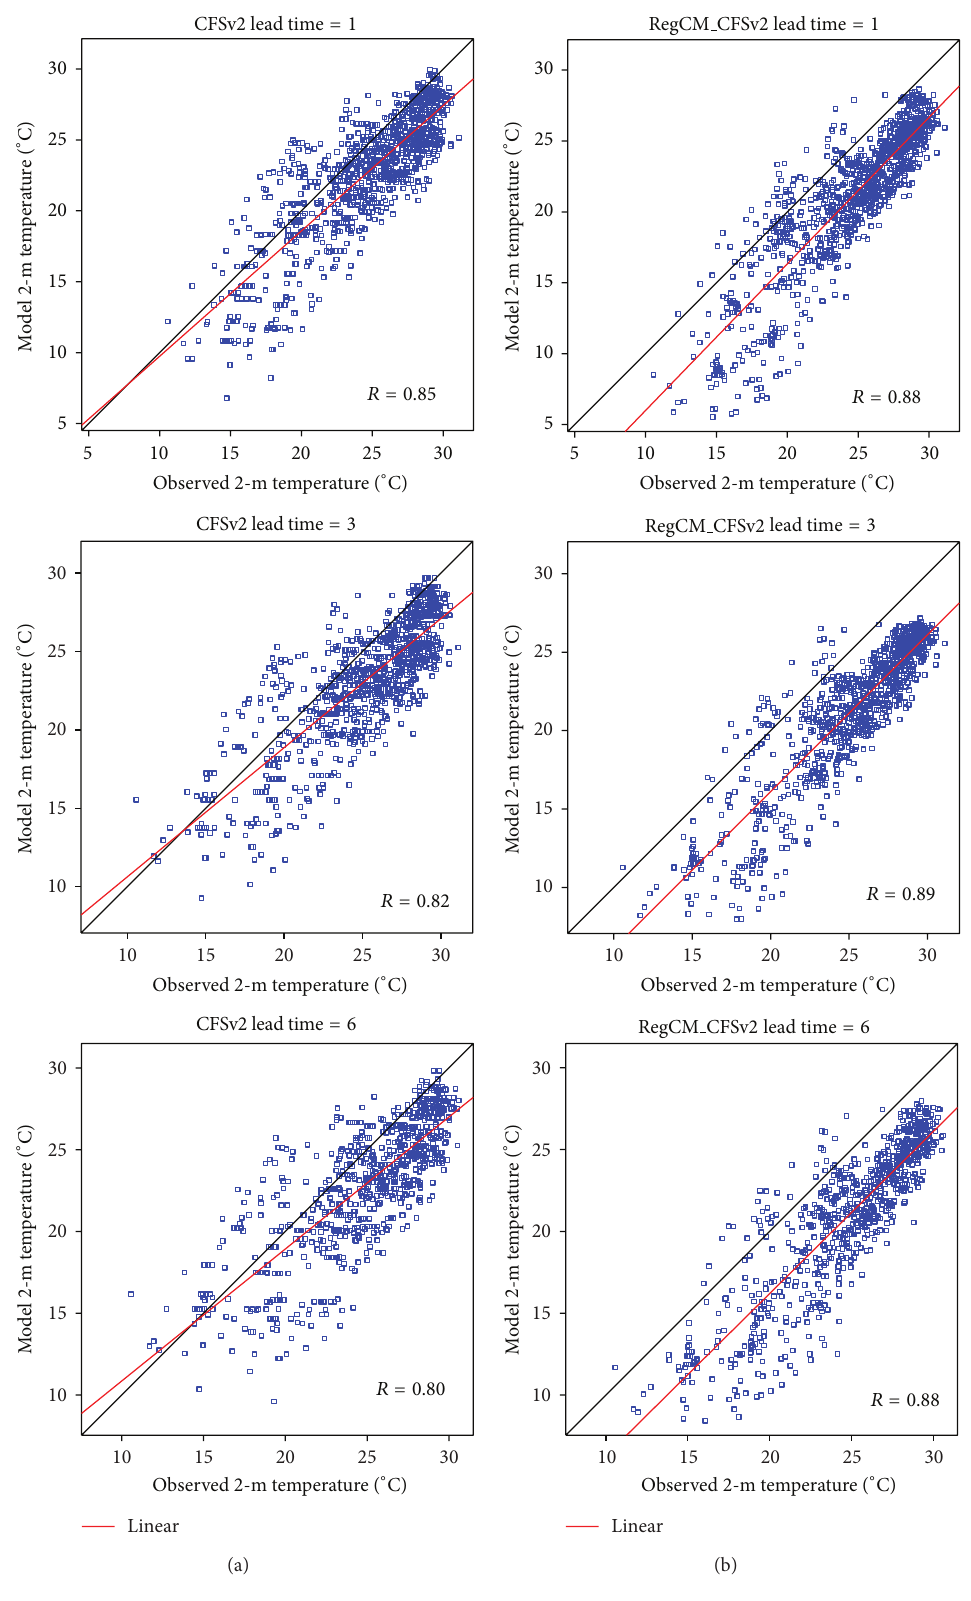
Figure 3: Relationship between observed and forecasted T2m ( ∘ C) by CFSv2 (a) and RegCM CFSv2 (b) for all stations, all target months from February 2012 to July 2013 with 1-, 3-, and 6-month lead times (top to bottom). Solid red line indicates the linear regression. Correlation coefficient ( 𝑅 ) is displayed at bottom right corner. The perfect regression line is presented by the black